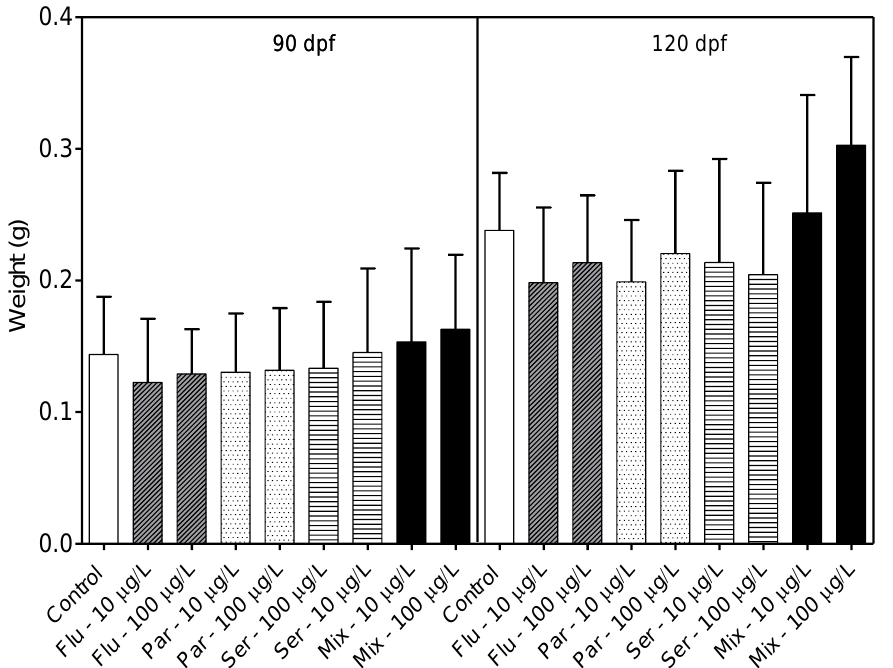
Figure 3. Weight of fish (g) measured at 90 and 120 days post fertilization (dpf). (Flu—Fluoxetine; Par—Paroxetine; Ser—Sertraline; Mix—Mixture). Statistical significance with respect to the control fish group was determined using a one-way ANOVA followed by a Dunnett’s multiple comparisons test.